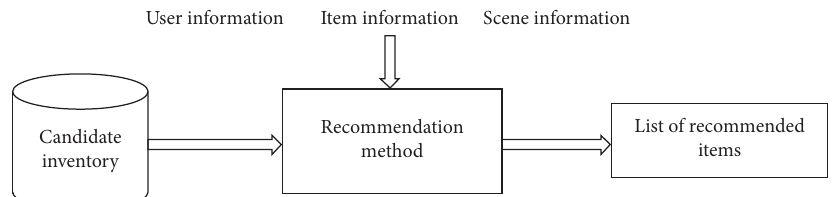
Figure 1: Personalized recommendation process.